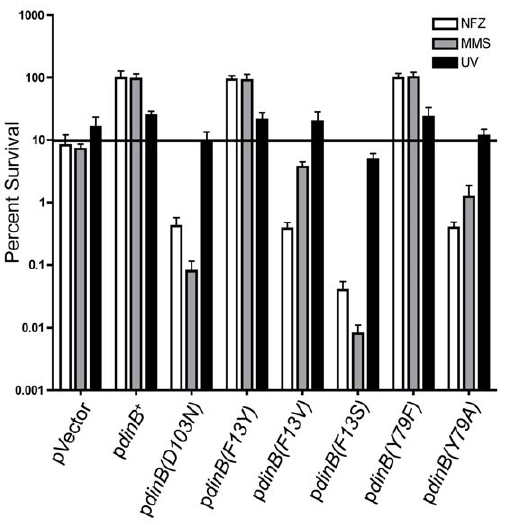
Figure 5. dinB deficient alleles affect D dinB survival only upon treatment with reagents that generate DinB cognate lesions. D dinB strains carrying the plasmid-borne variants of DinB were compared at levels of UV (37 J/m 2 ) at which D dinB and dinB + are equally killed (black bars). Significant variations in survival were only observed upon comparable levels of MMS (7.5 mM; gray bars) or NFZ (0.008 mM; white bars) treatments. Error bars represent the standard deviation of the mean from at least 3 independent experiments. Only top error bars are shown for clarity.